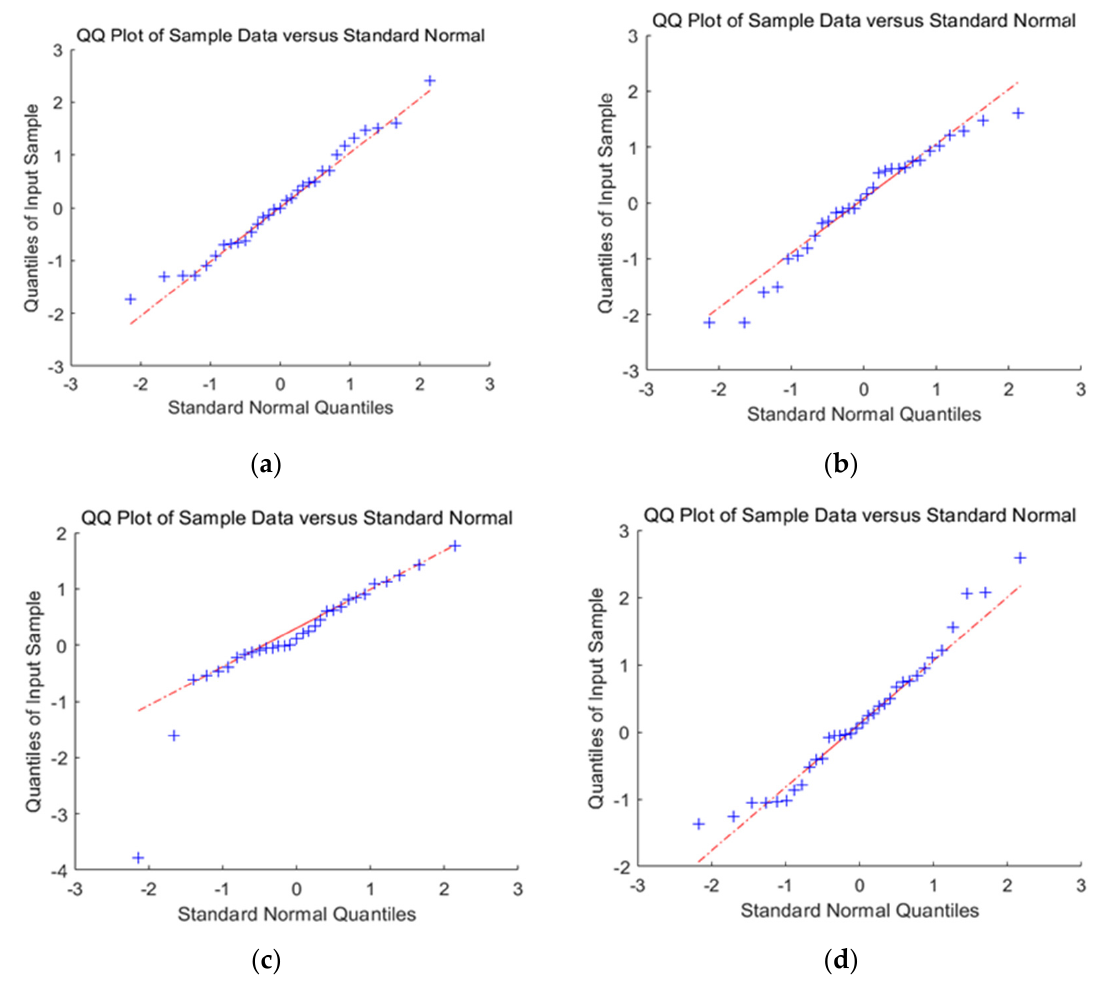
Figure 8. Erd of B1 and B2 and residual test of mass prediction model QQ-Plot; ( a ) QQ-plot of B1 mass prediction; ( b ) QQ-plot of Erd prediction of B1; ( c ) QQ-plot of B2 mass prediction; ( d ) QQ-plot of Erd prediction of B2.